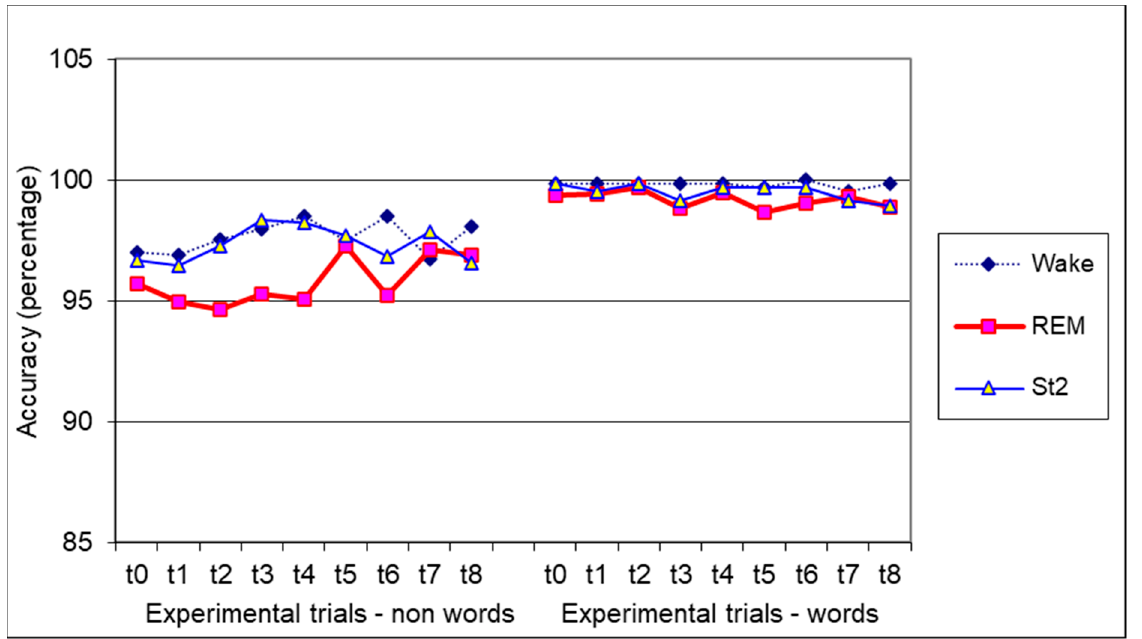
Figure 1. Accuracy (expressed as percentage) in the lexical decision task for non-words and words. Means are shown.